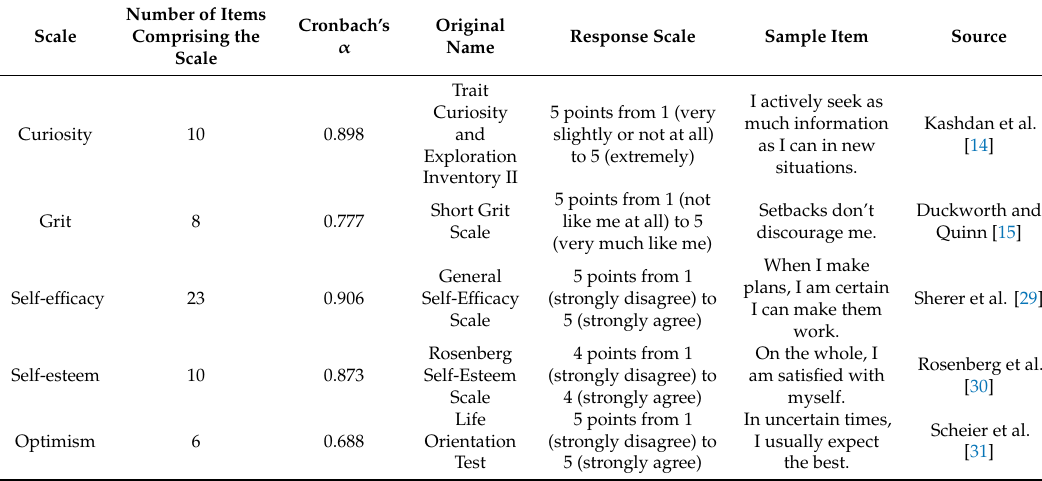
Table 1. Description of the scales used in this